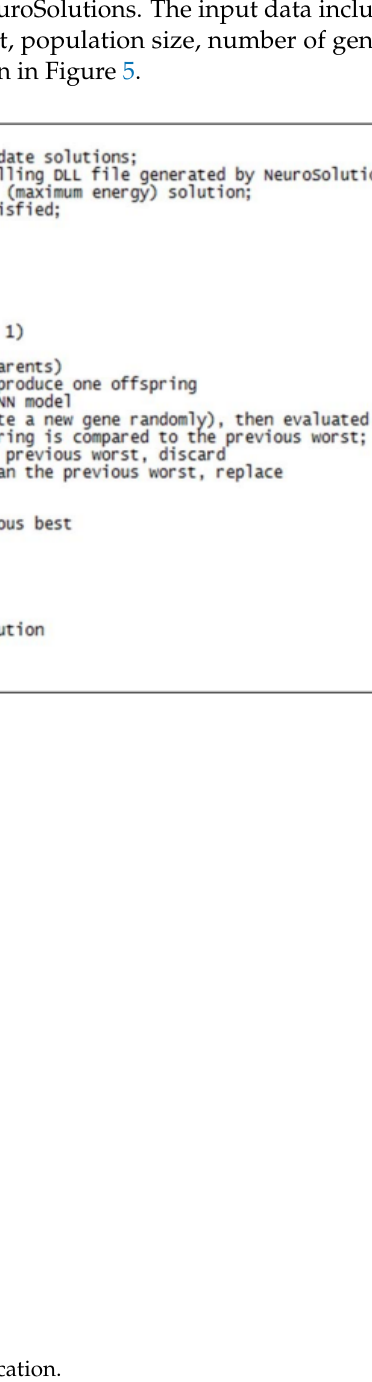
10 of 20 Table 1. GA control parameters sets. Control Parameter